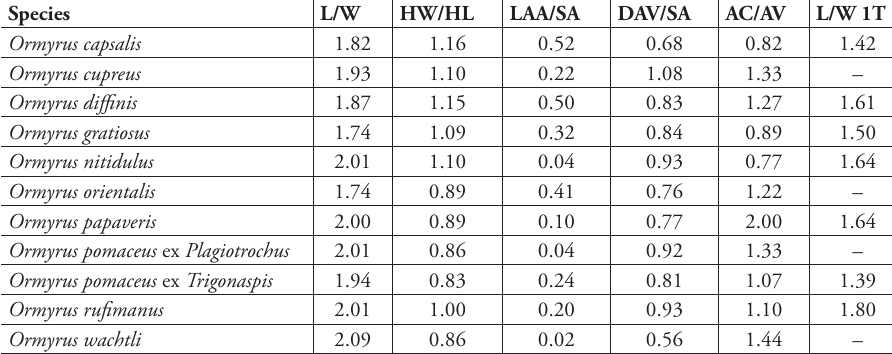
Table 2. Morphological measurements and ratios of studied specimens meaning as follows: body maxi- mun length/width (L/W); head maximun length/width (HW/HL); distance between antennae/length of the antero-medial setae of the antennal area (LAA/SA); distance between antennae/distance between the antero-medial setae of vertex (DAV/SA); distance between the antennae to the anterior margin of clypeus/ distance between the antennae to the upper margin of vertex (AC/AV); maximum length/width of the mandible tooth (L/W